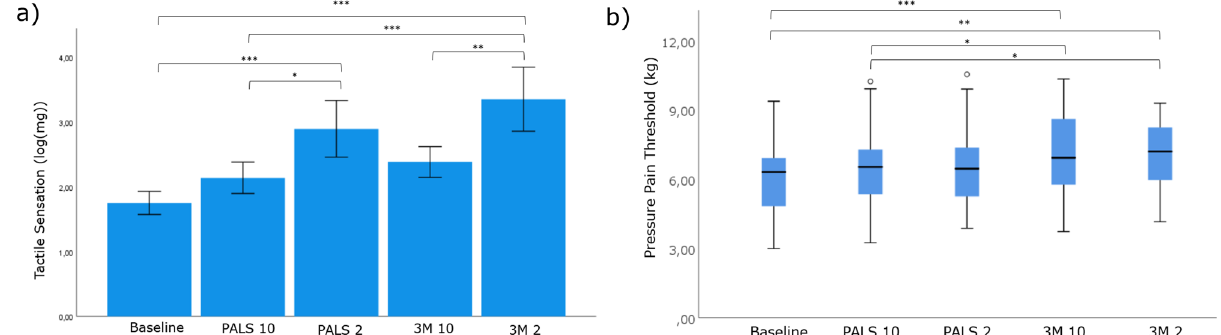
Figure 3. ( a ) Mean tactile sensation with the Semmes–Weinstein Monofilament test. Values for tactile sensation were transformed from a logarithmic scale to a linear scale to perform analysis. * p < 0.05; ** p < 0.01; *** p < 0.001, one-way ANOVA with Bonferroni adjustment. ( b ) Pressure pain threshold test with the pressure algometer. Values for pressure pain threshold are presented in a boxplot. * p < 0.05; ** p < 0.01; *** p < 0.001, Wilcoxon Signed Rank test.